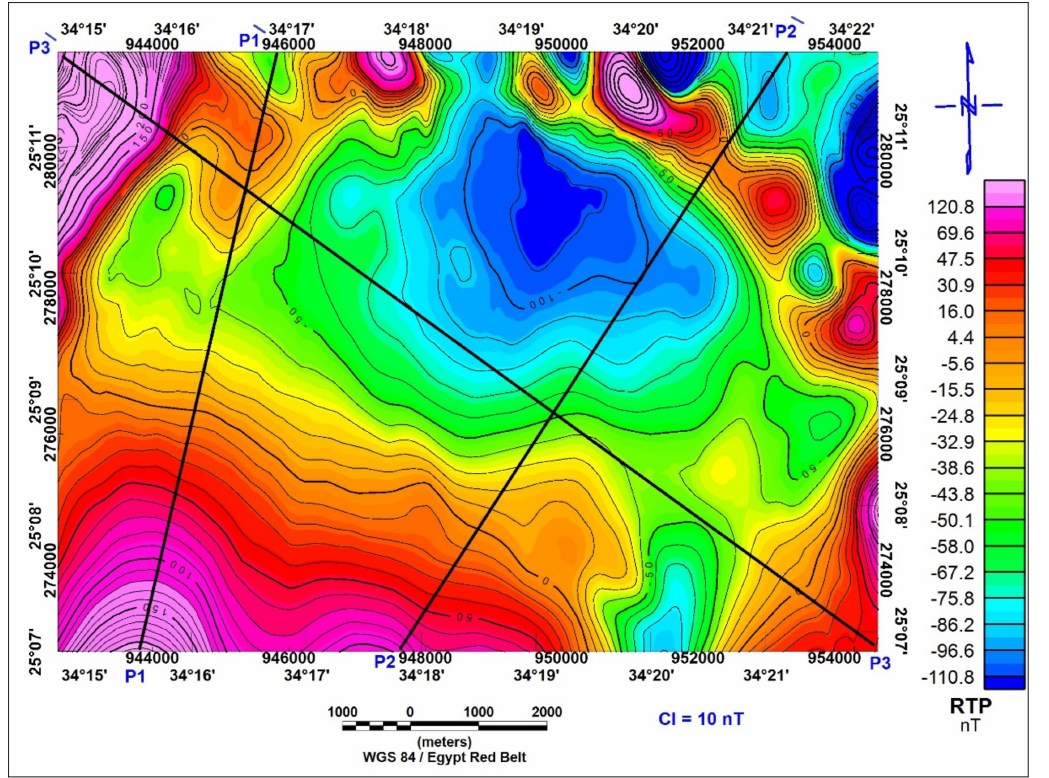
Figure 8. RTP aeromagnetic anomaly map of the studied area showing the profiles used for applica- tion of analytical signal.